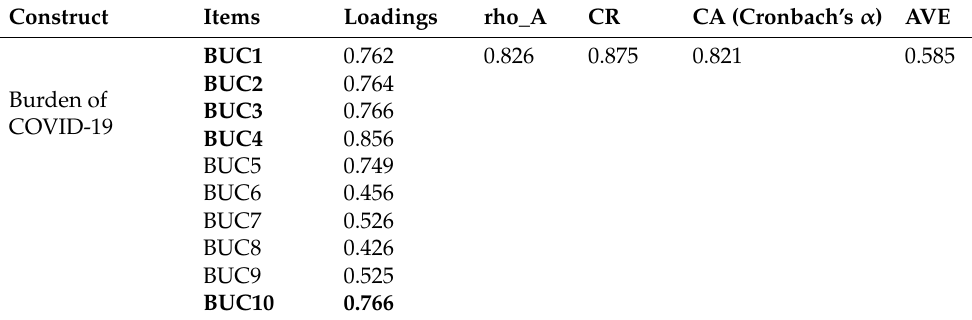
Table 2. Reliability and convergent validity for research constructs. BUC = burden of COVID-19, STR = perceived stress, DEP = depression, BIO = preferences for biophilic design, NAT = perceived benefits of